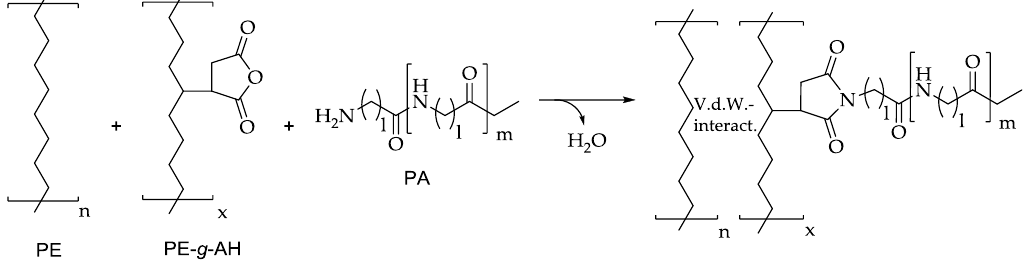
Figure 3. Compatibilization mechanism of PE and PA using PE- g -MA. Adapted from [89].